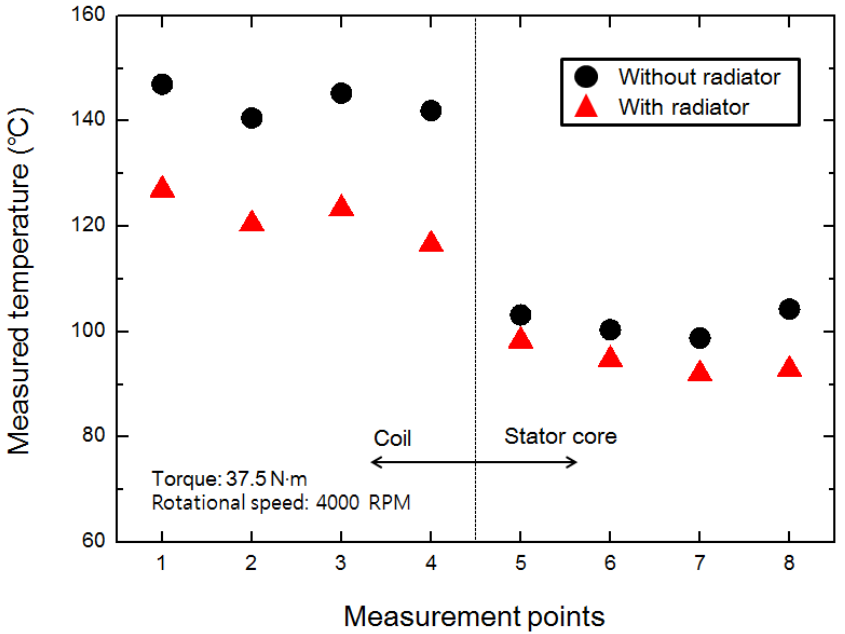
Figure 5. Steady-state temperature comparison of motor cooling systems under conditions of continuous-rating base speed with (closed circles) and without (closed triangles) a